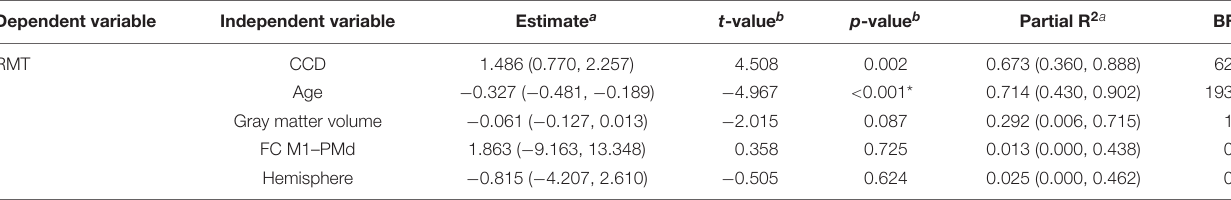
TABLE 6 | Combined linear mixed model for the subgroup and both